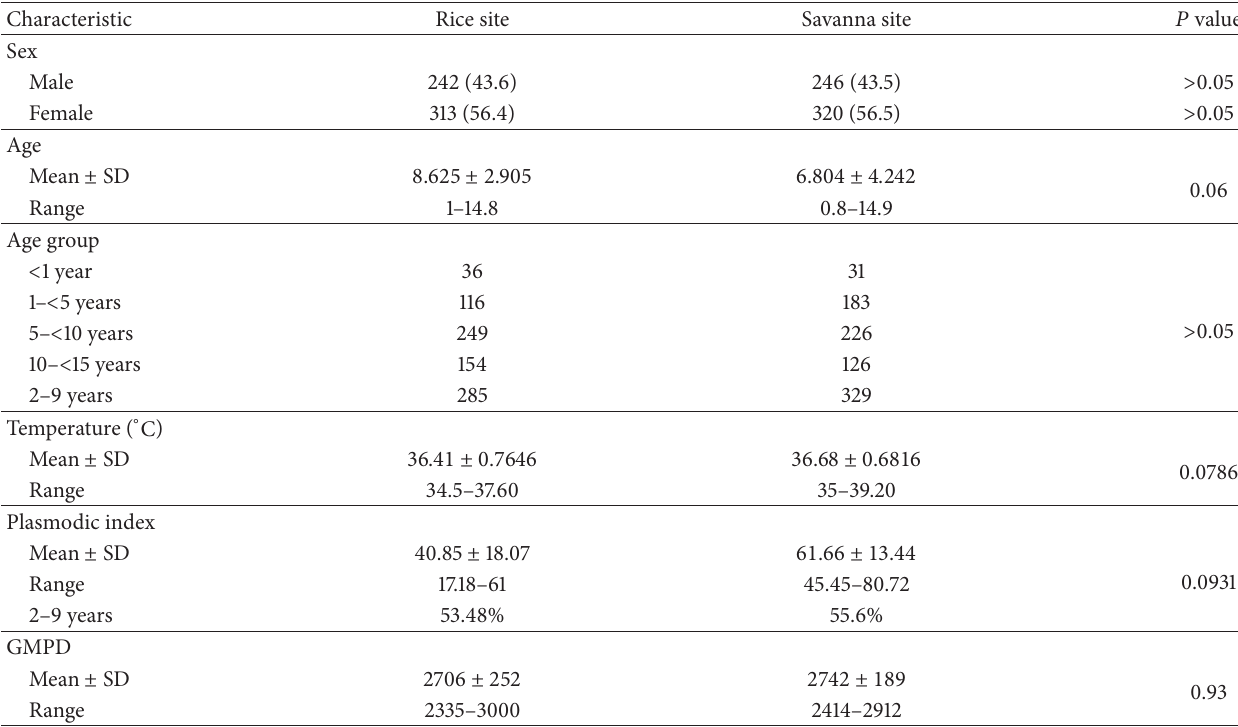
Table 1: Study participant’s